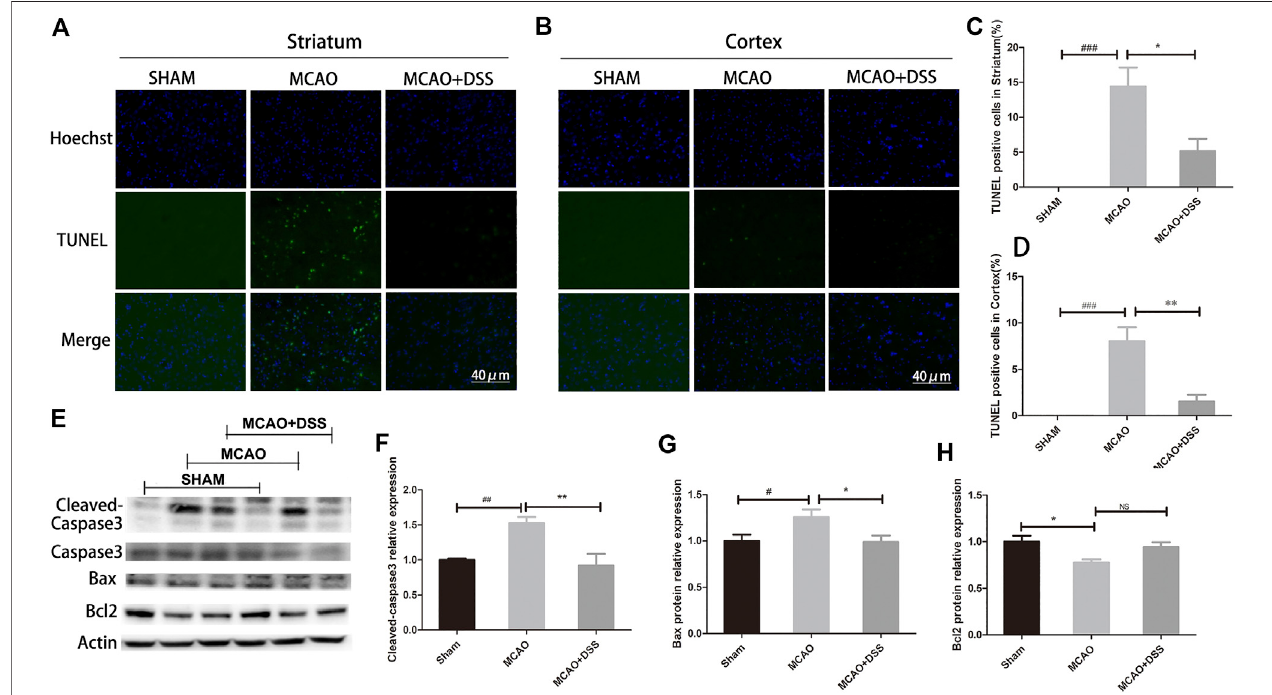
FIGURE2|| DSSethanolextractinhibitedtheexpressionofthecleaved-caspase3andBax,andattenuatedapoptoticcelldeathinischemia-reperfusedratbrains. DSSethanolextractwassimplynamedasDSS.Sham:shamcontrolgroup;MCAO:MCAOischemia-reperfusiongroup;MCAO+DSS:MCAOplusDSSethanolextract treatment. Th rats weresubjected to2 h ofMCAOischemia plus 22 h ofreperfusion. The DSS ethanolextract at the dosage of12 g/kg wasorallyadministratedinto the rats at 30 min before reperfusion after 1.5 h MCAO ischemia. (A) Co-immunostaining TUNEL (green) and DAPI (blue) in the striatum of the ipsilateral side. (B) Co- immunostainingTUNEL(green)andDAPI(blue)inthecortexoftheipsilateralside. (C) StatisticanalysisofTUNELpositivecellsinthestriatumoftheipsilateralside.Versus Shamcontrol, ### p < 0.001;VersusMCAO,* p < 0.05, n (cid:2) 4. (D) StatisticanalysisofTUNELpositivecellsinthecortexoftheipsilateralside.VersusShamcontrol, ### p < 0.001;VersusMCAO,** p < 0.01, n (cid:2) 4. (E) Representativeimmunoblotresultsofcleaved-caspase3,BaxandBcl-2inthebraintissues. (F) Statisticanalysisofcleaved- caspase3 expression in the brain tissues. Versus Sham control, * p < 0.05, n (cid:2) 8. (G) Statistic analysis of Bax expression in the brain tissues. Versus Sham control, # p < 0.05; Versus MCAO, * p < 0.05, n (cid:2) 8. (H) Statistic analysis of Bcl-2 expression in the brain tissues, n (cid:2) 8.